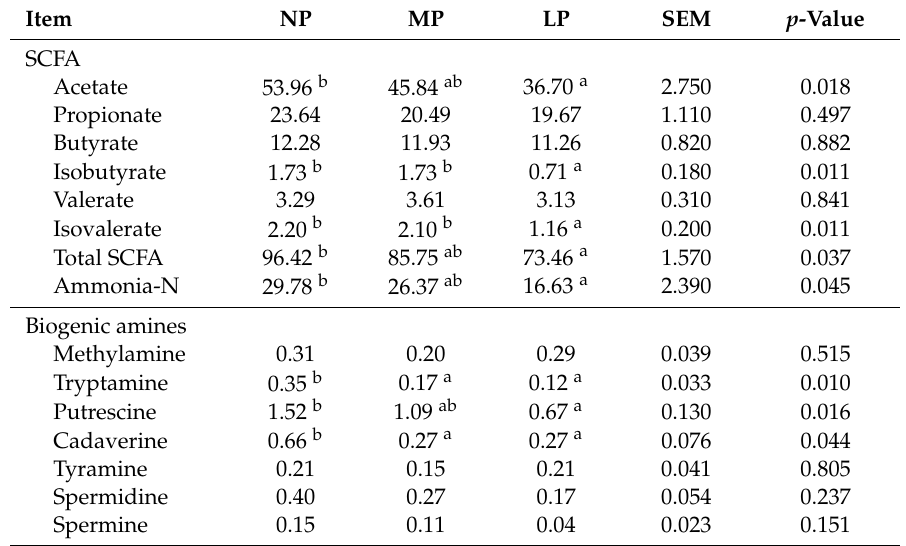
Table 8. Concentrations of short chain fatty acids, ammonia-N, and biogenic amines in the colonic digesta of pigs, µ mol /